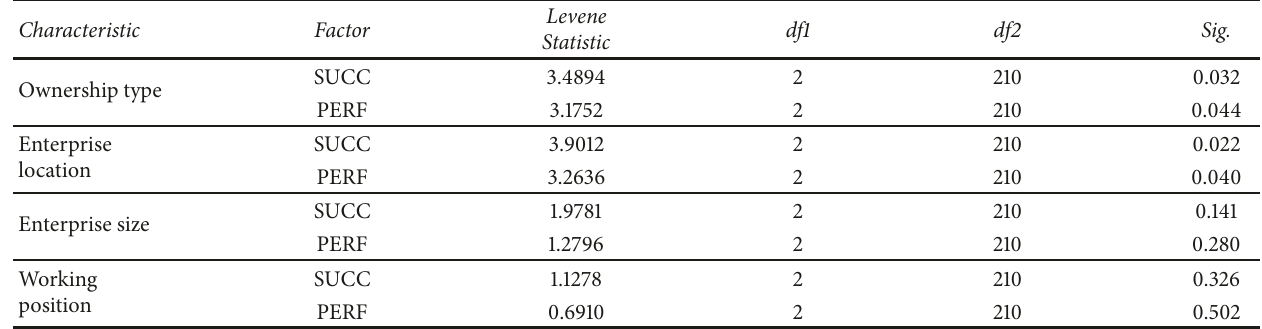
Table 8: Tests of homogeneity of